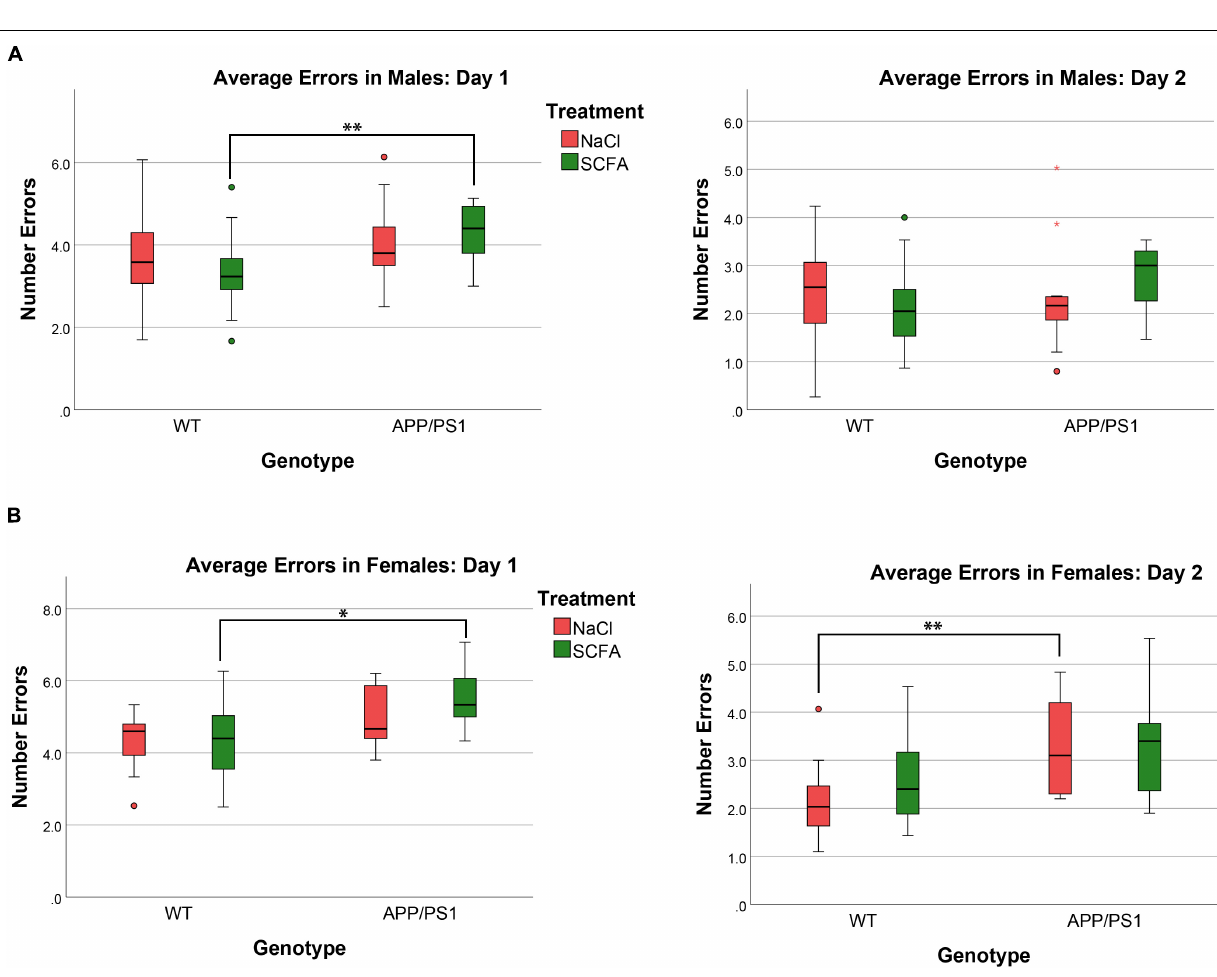
Frontiers in Neuroscience |